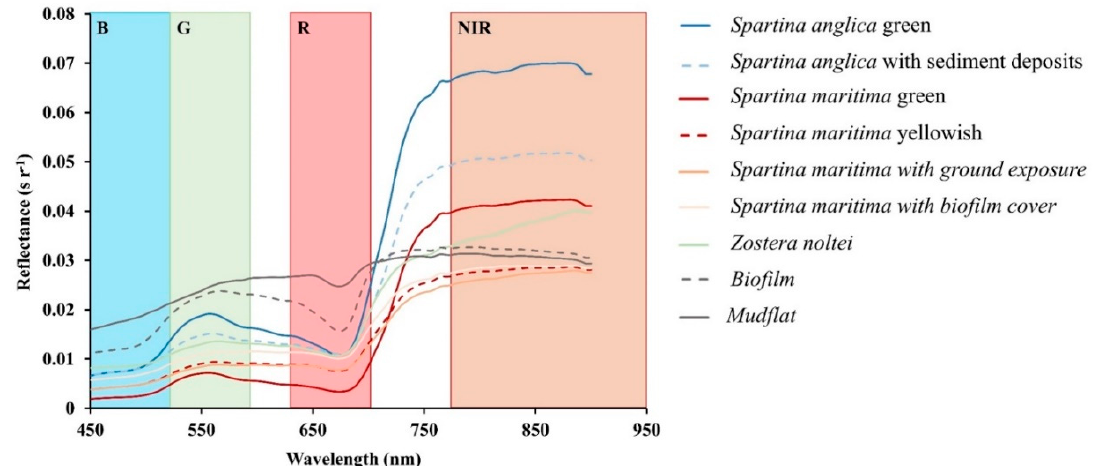
Figure 4. Mean field remote sensing reflectance (sr − 1 ) spectra of different characteristic substrate types, collected in the study site on July 21, 2016. Colored spectral bands are associated with the blue (B), green (G), red (R), and near-infrared (NIR) channels of the Pl é iades-1 satellite images. Table 2. Mean (standard deviation) values of field hyperspectral, field SRF-corrected Pl é iades, and Pl é iades remote sensing reflectance (sr − 1 ) in the Green, Red, and NIR bands, and in the NDVI Figure 5 provides the R rs values in the green, red and NIR channels for the MS Pléiades images, pseudo-band for the same dense and green Spartina anglica and Spartina maritima patches (see Figure 6). Field data were acquired on 21 July 2016, and the Pl é iades image was acquired on 3 August 2016. Field R rs (sr − 1 ) Field R rs_SRF (sr − 1 ) Pl é iades R rs (sr − 1 ) Spectral Band (nm) S.